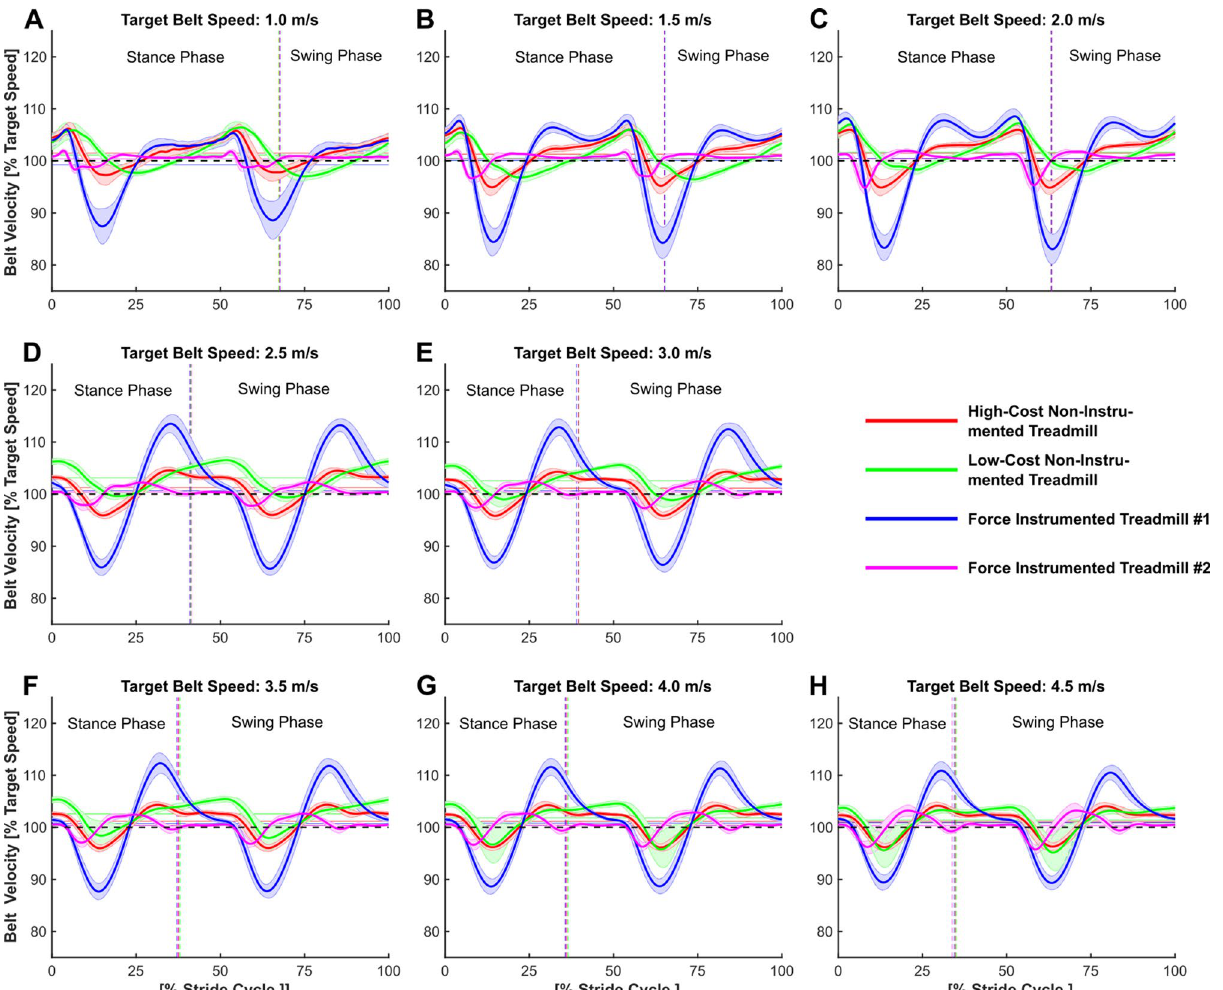
Figure 3. Ensemble averages of treadmill belt velocity profiles of the four different treadmill types analyzed at three different walking target speeds (1.0–2.0 m/s, A – C , respectively) and five different running target speeds (2.5–4.5 m/s, D – H , respectively). Solid lines indicate the mean (n = 7) of the particular treadmill condition. The shaded areas display ± one standard deviation around the mean. Data is time-normalized to the entire gait cycle (from right leg initial ground contact to next ipsilateral ground contact). Vertical broken lines indicate the final contact of the right foot with the ground